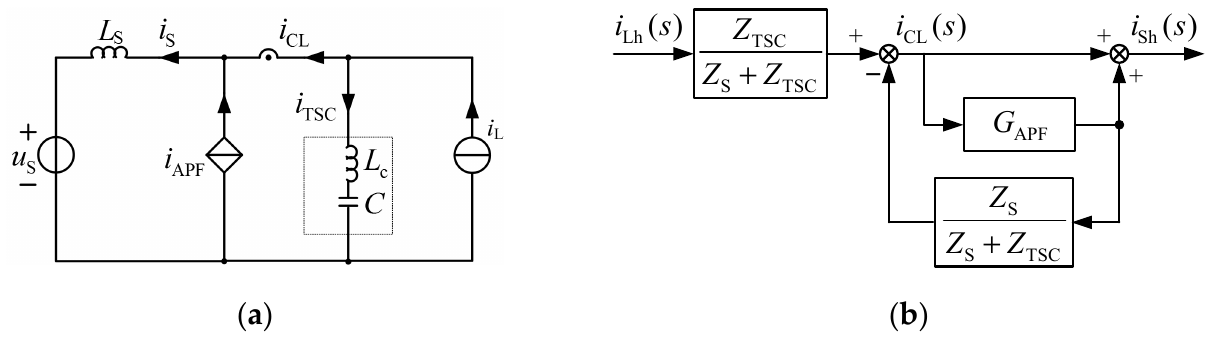
Figure 12. Analysis of hybrid system: ( a ) single-phase equivalent circuit; ( b ) control diagram.